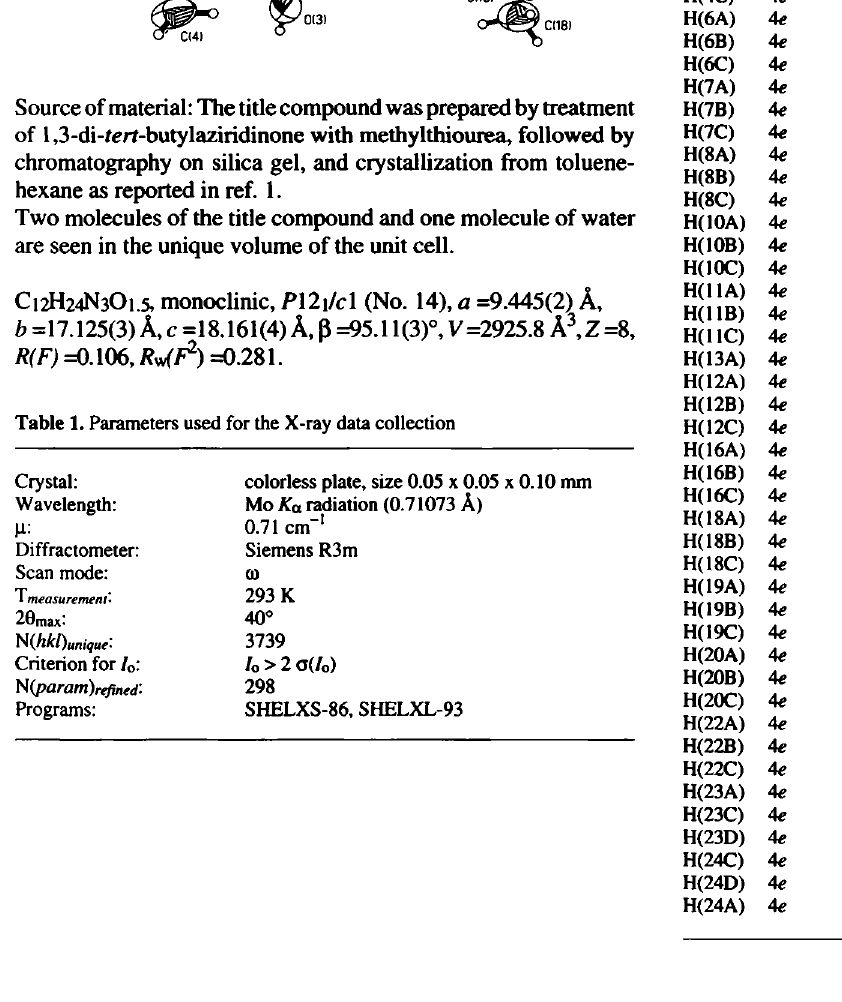
Table 2. Final atomic coordinates and displacement parameters (in Л^)